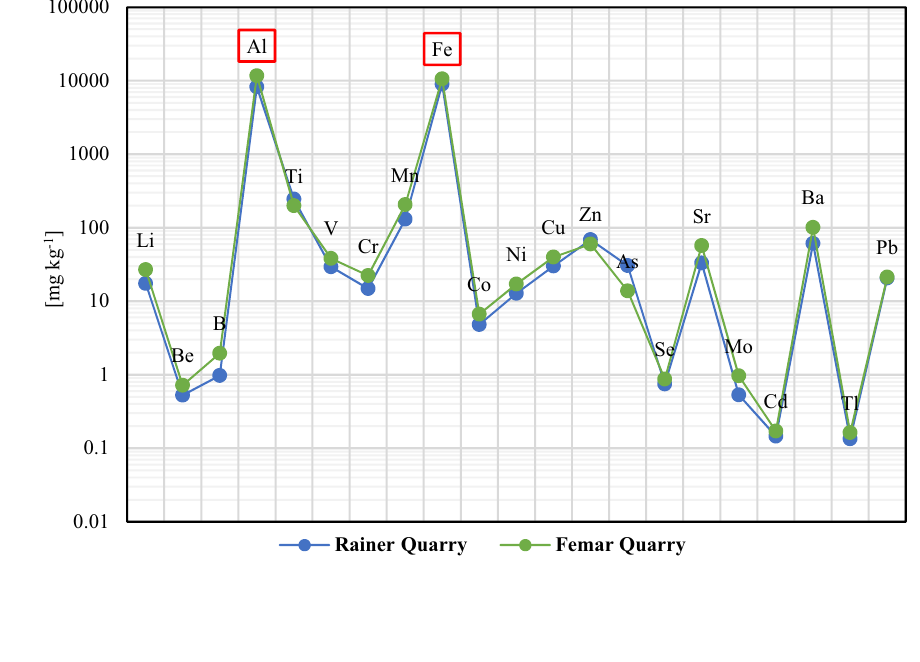
Fig. 4 Localization of case studies in Lazio